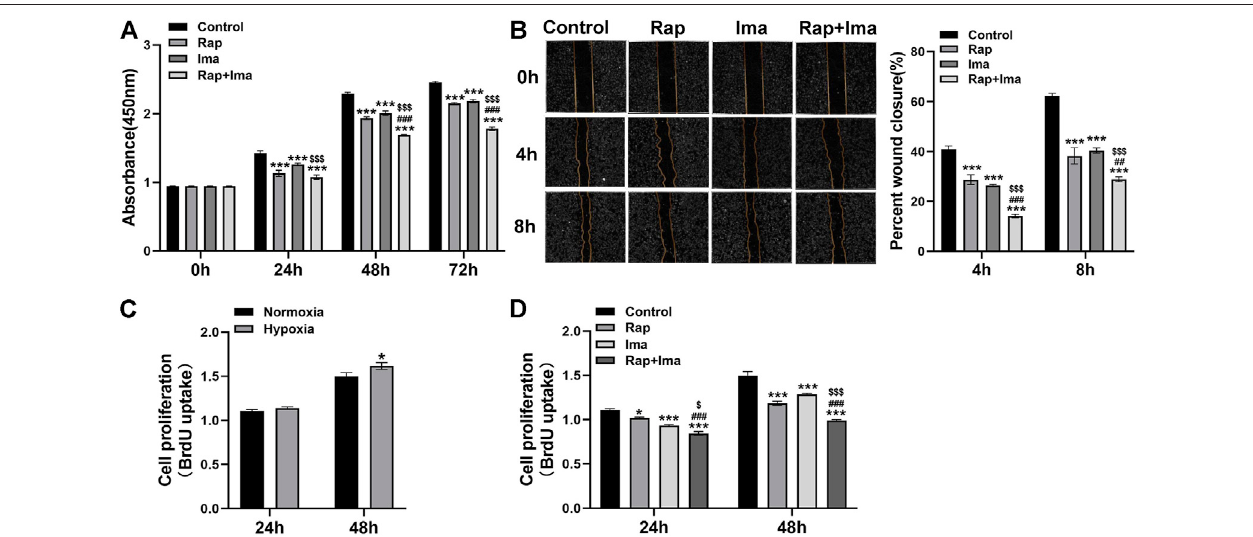
FIGURE3| Effectsofrapamycincombinedwithimatinibontheviability,proliferationandmigrationofhPASMCs. (A) Cellviabilitywasdeterminedbymeasuringthe absorbance at 0, 24, 48 and 72 h after different drug treatments. (B) A scratch was applied to cell monolayers, and migration of the cells towards the wound was recordedbyphotomicrographsat0,4,and8h( n (cid:2) 3);summarizeddatashowingpercentwoundclosure[(0hwoundarea – 4hor8hwoundarea)/0hwoundarea]*100%. (C) BrdU assay was performed to determine hPASMCs proliferation under normoxia and hypoxia (3% 0 2 ) for 24 and 48 h. (D) BrdU assay was performed